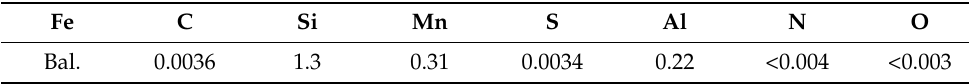
Table 1. Composition of non-oriented silicon steel (mass fraction %).